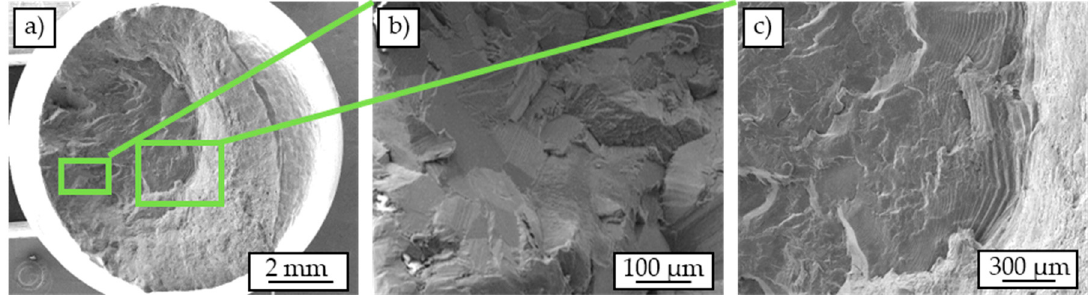
Figure 11. Scanning electron micrographs of a cast-based specimen tested in a constant amplitude test ( σ a = 120 MPa): overview ( a ), crack course along grain boundaries ( b ), striations ( c ).